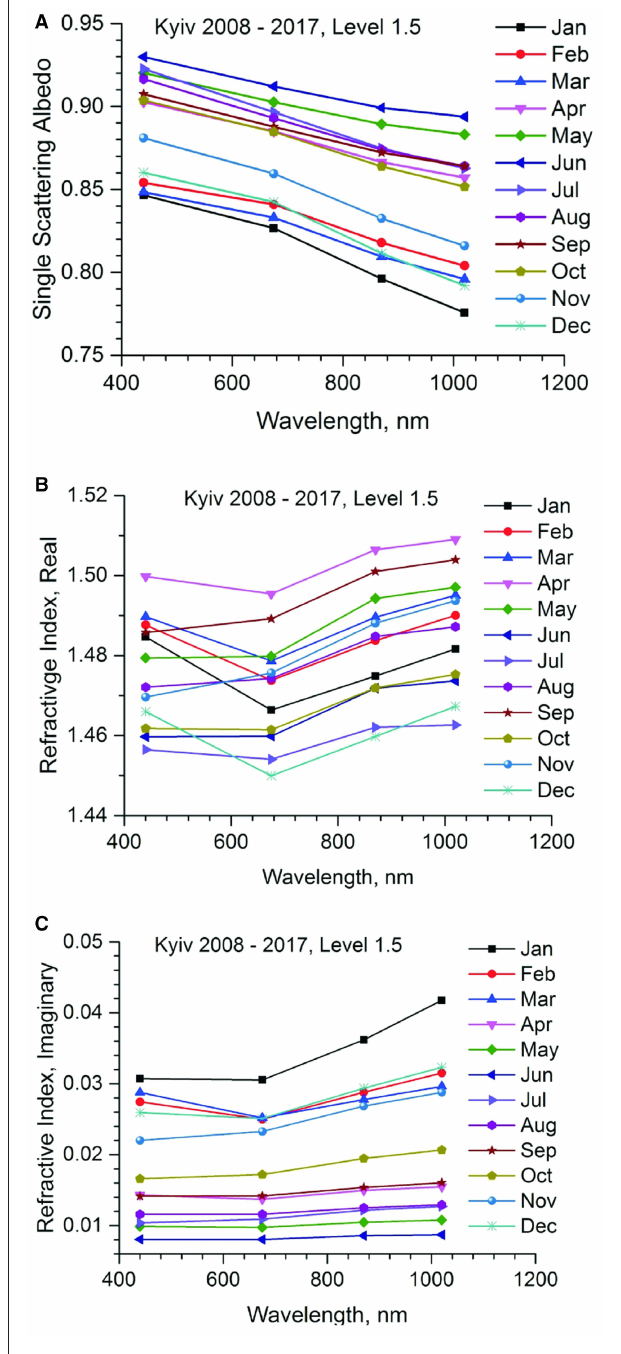
FIGURE 12 | Seasonal variations of (A) single-scattering albedo, and (B,C) refractive index spectral dependences according to data from the Kyiv AERONET